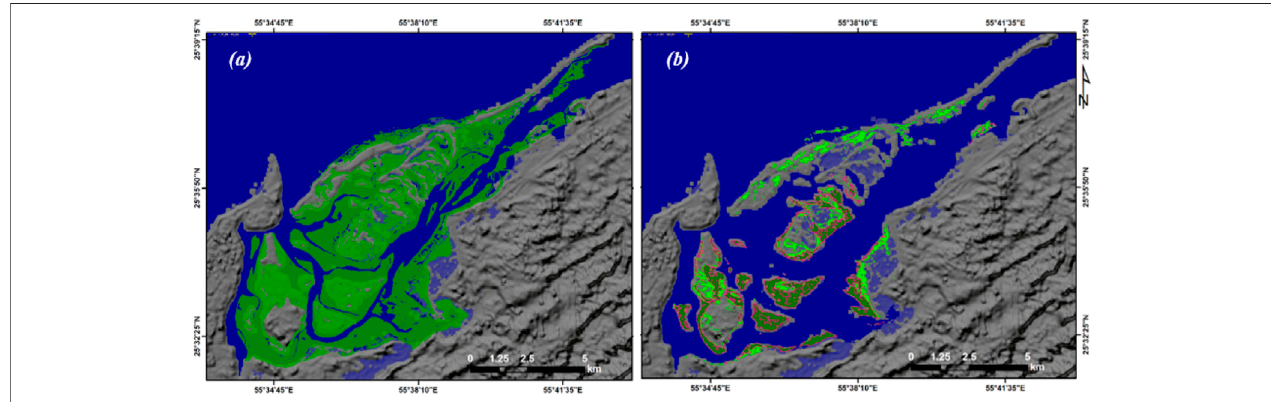
FIGURE 5 | Mangroves extracted from the Sentinel-2 image (A) and those extracted from Landsat image (B) for the year 2020.